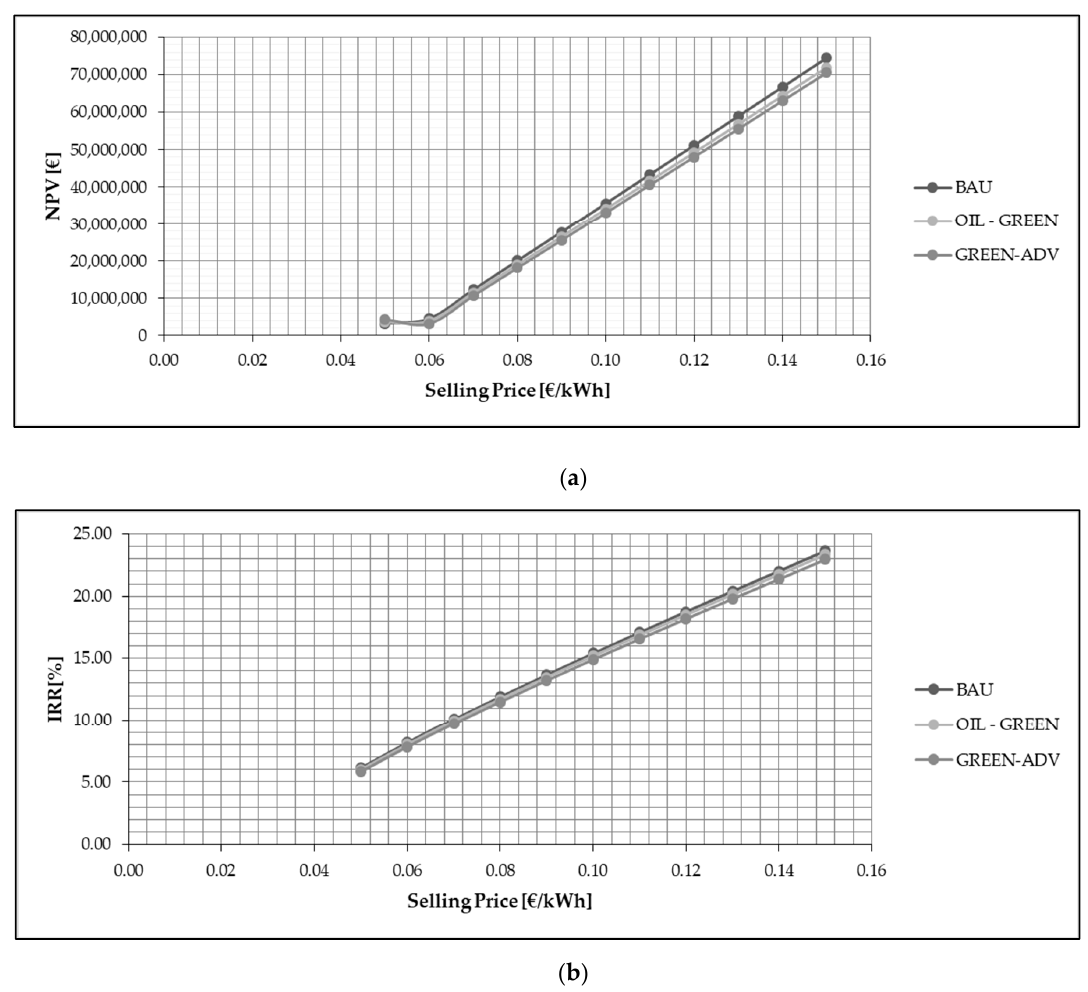
Figure 8. ( a ) NPV and ( b ) IRR indices for each scenario and for the PSP produced energy selling price variation from 0.05 to 0.15 €/kWh.